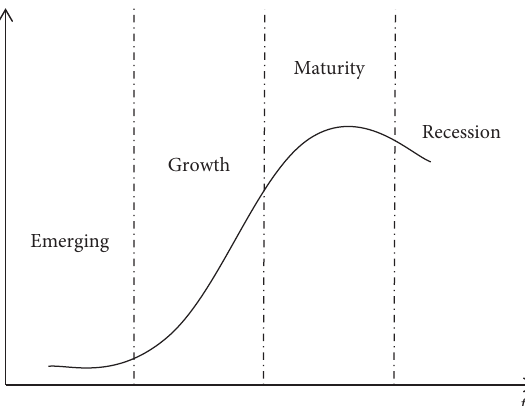
Figure 4: The life cycle curve of